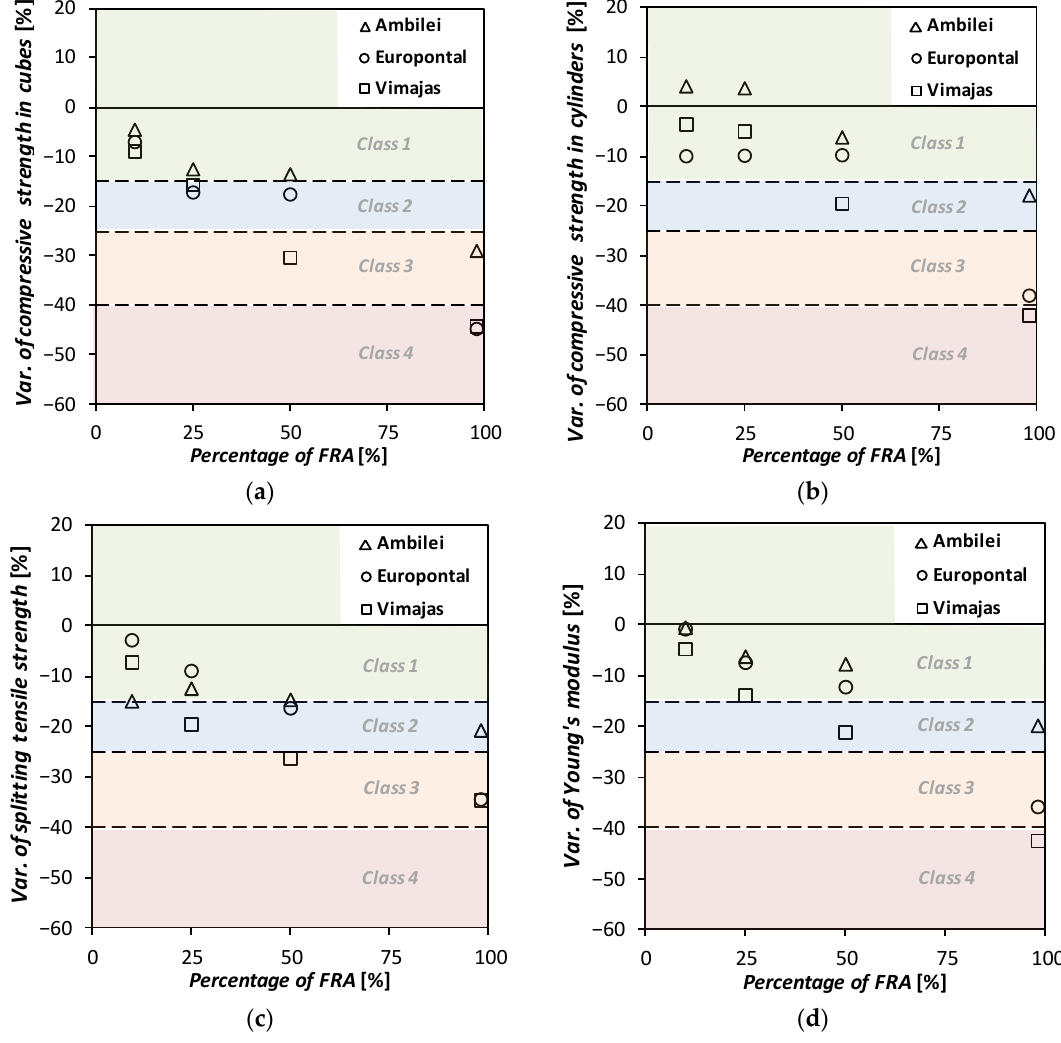
Figure 2. Variation of compressive strength in ( a ) cubes and ( b ) cylinders, ( c ) of splitting tensile strength and ( d ) of Young’s modulus of concrete made with FRA, relative to the reference concrete.